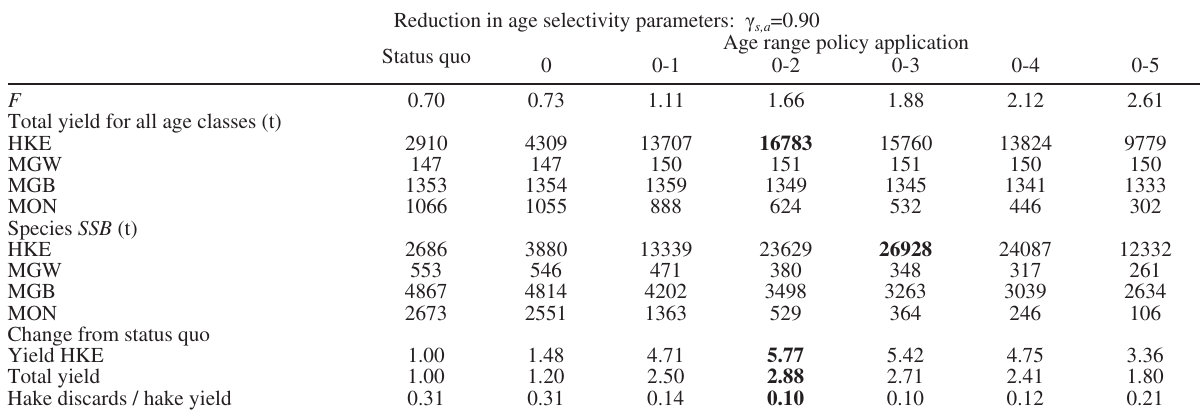
Table 1. – Improving age selectivity by age ranges in the SIHS fishery. Reference points, F , represent the fishing mortality that maximizes the present value of the total yield of the fishery as defined by Equation 1 using a discount factor β =0.95. Yield represents the stationary value of the valid catches (without discards) as defined by Equation 2 under the optimal F . The status quo represents the situation in which the selectivity parameter does not change ( γ =0). Values in bold represent the best scenario for each variable. s,a Reduction in age selectivity parameters: γ =0.90 s,a